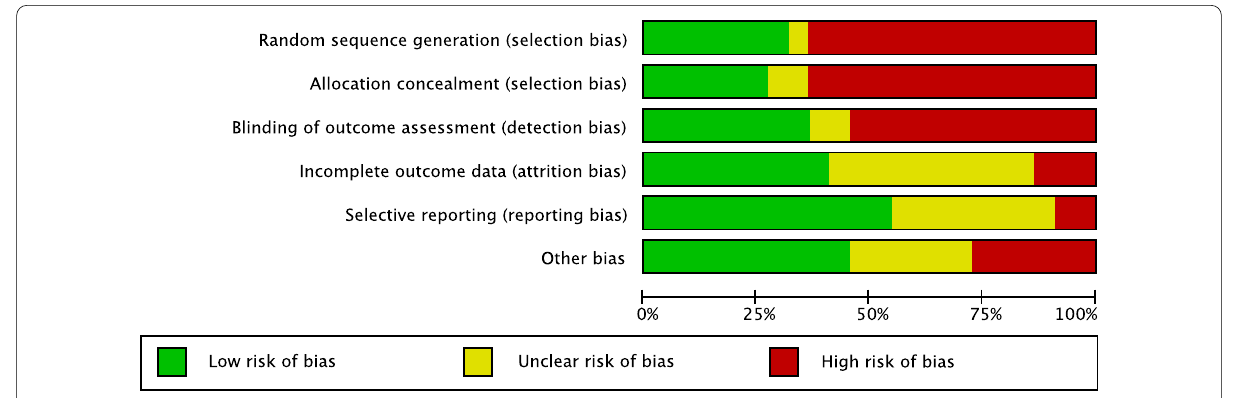
Fig. 2 Methodological quality assessment